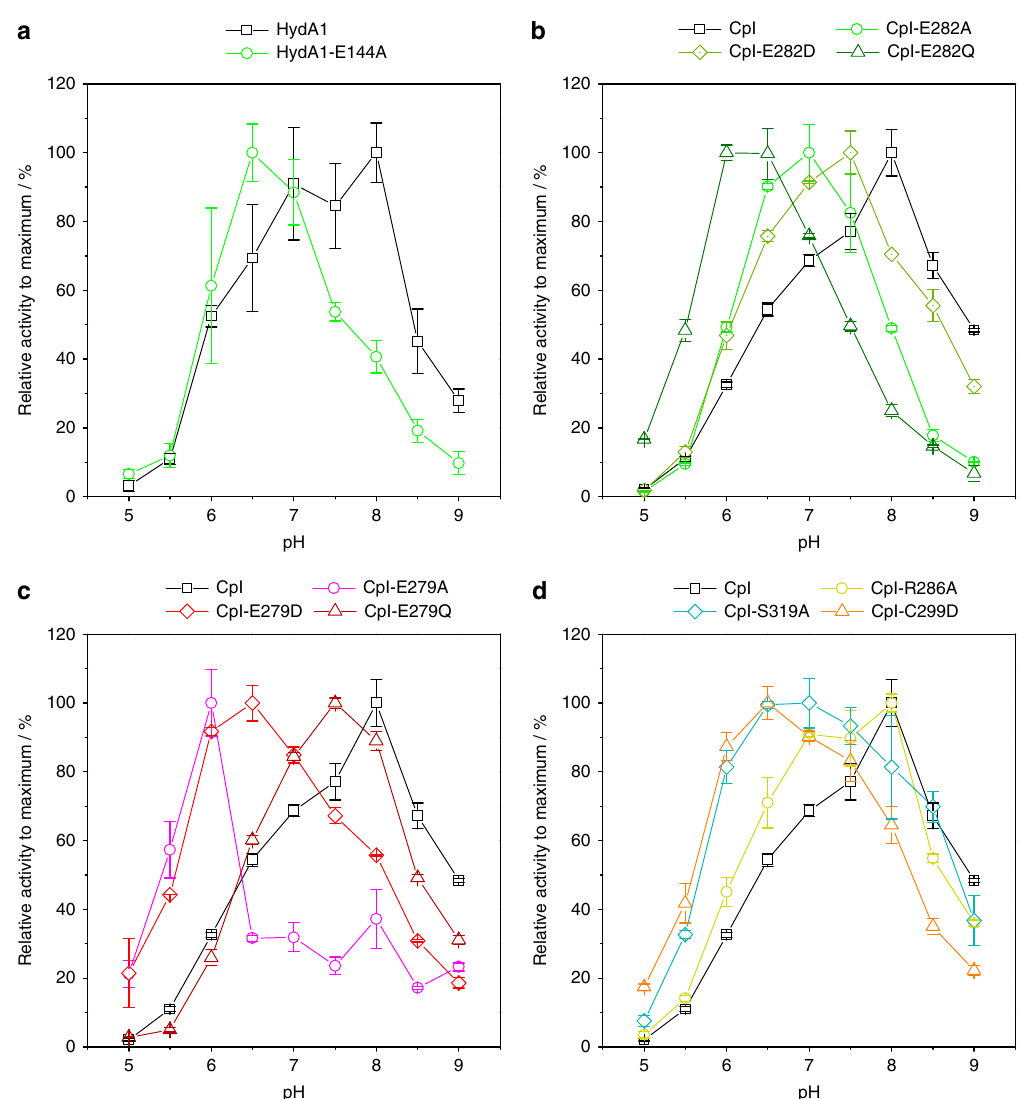
Fig. 2 pH-activity pro fi les of wt-CpI and wt-HydA1 compared to selected SDM variants. a HydA1 and E144A; b wt-CpI and variants of position E282; c wt- CpI and variants of position E279; d wt-CpI and selected variants of positions R286, S319, and C299. H 2 production activities were determined for different buffers, covering a pH gradient between 5 and 9 in steps of 0.5 pH units. Relative values correspond to % of maximum activity obtained throughout the entire pH gradient. Black plots indicate the relative pH-dependent activities of CpI and HydA1 wild-type enzymes. All values are mean values ± standard deviations from at least three independent